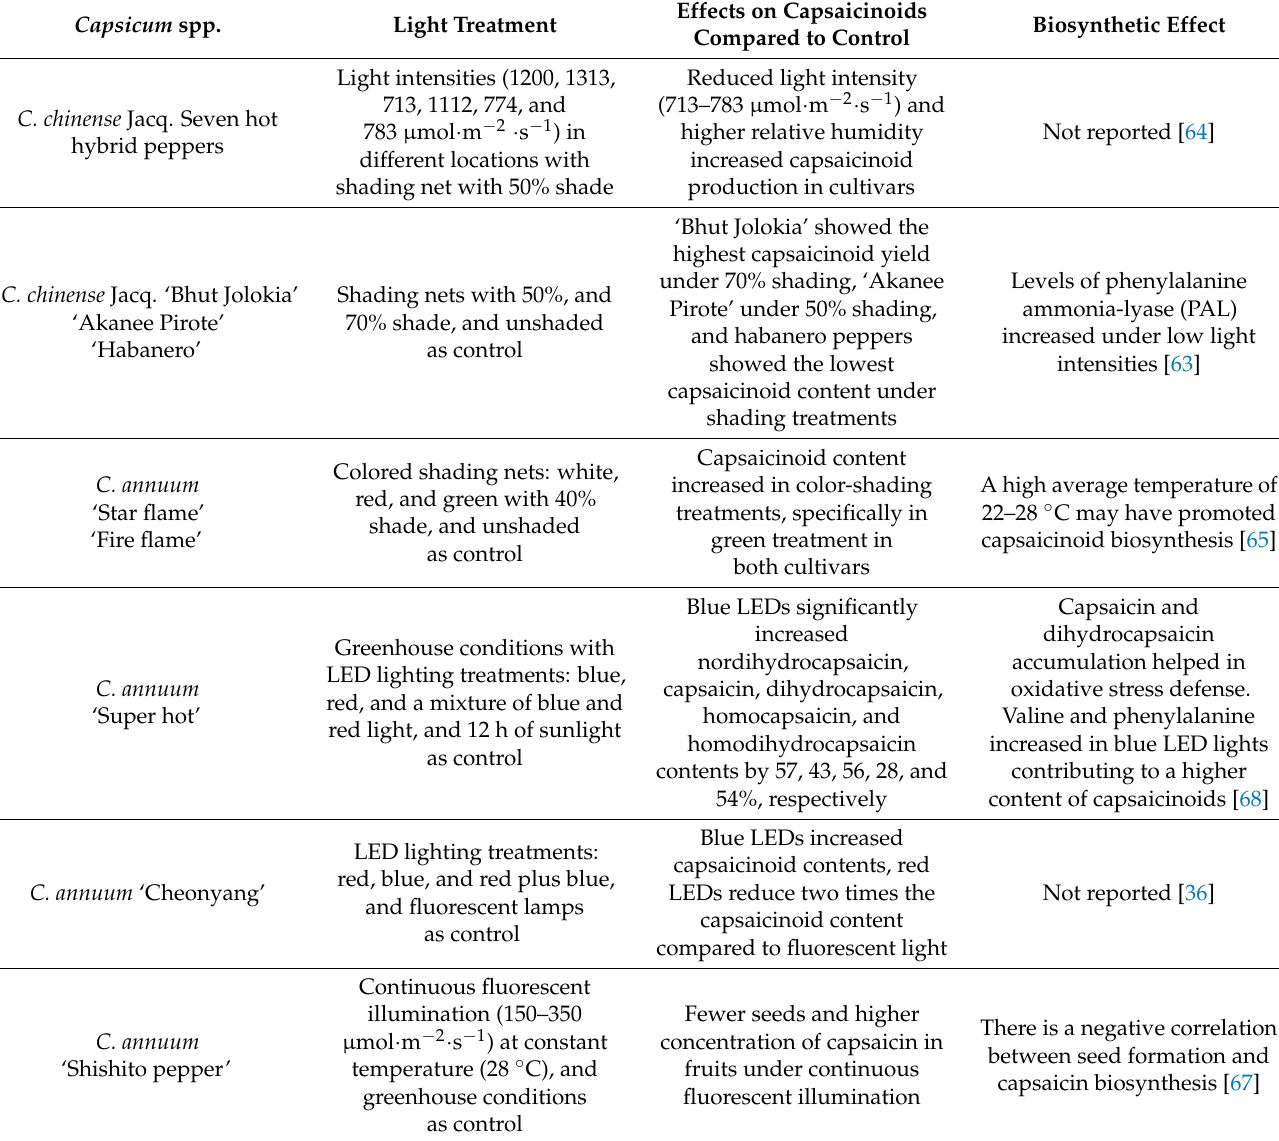
Table 1. Effect of light condition treatments on the capsaicinoid content in Capsicum species. Capsicum spp. Light